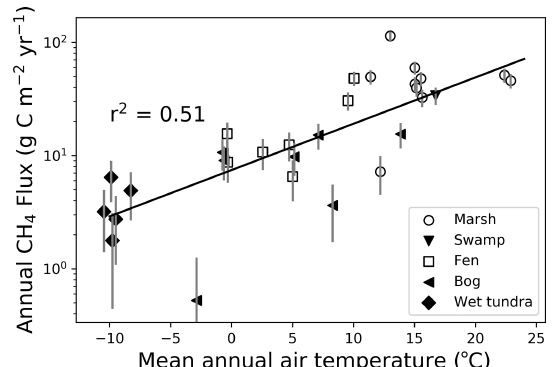
Figure 4. Histogram of annual methane fluxes ( F CH gCm − 2 yr − 1 ) grouped by site type.